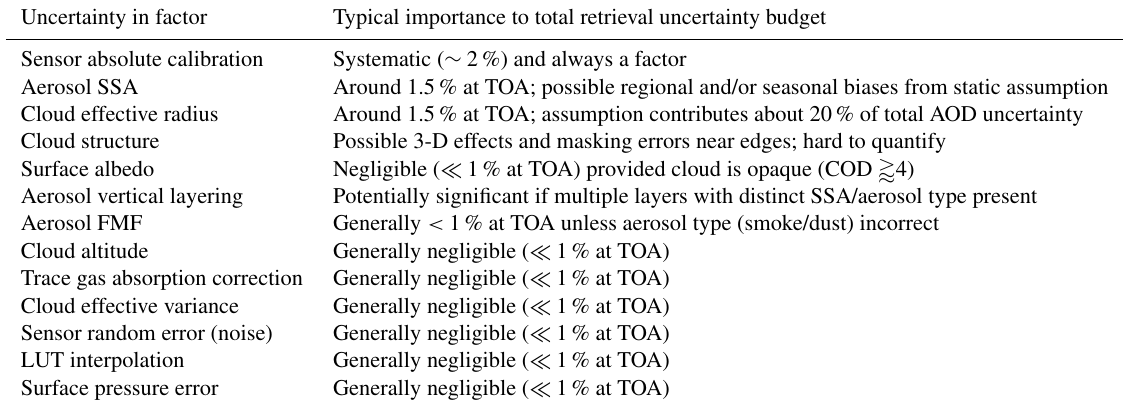
Table 2. Magnitude of the main contributions to the total uncertainty on the TOA signal. Uncertainty in